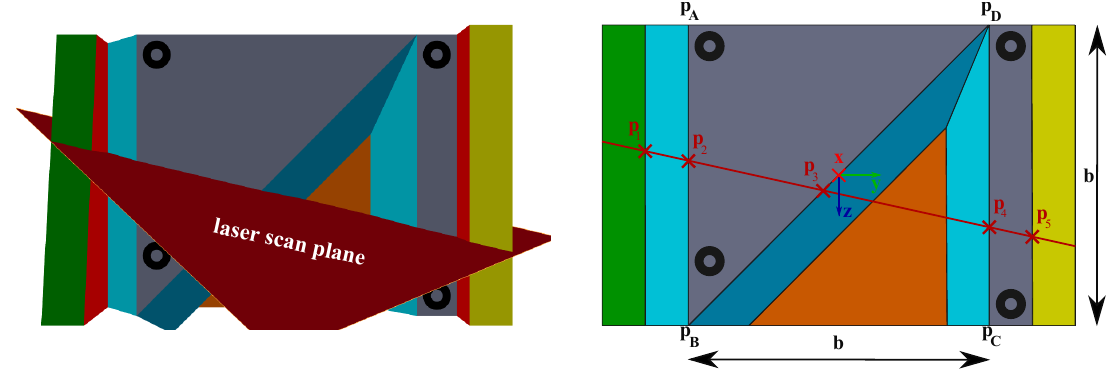
Figure 2. 3D model sensed by the camera and laser rangefinder ( left ) and its schematic representation ( right